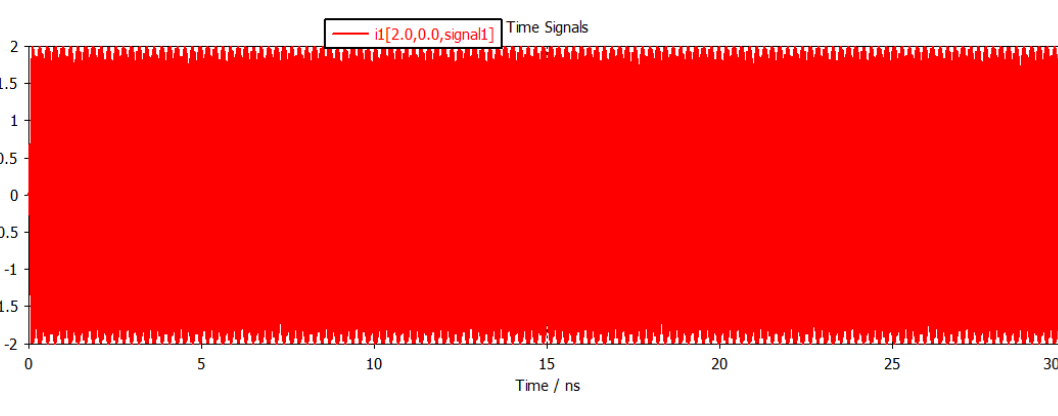
Figure 17. Frequency spectrum of the output signal.